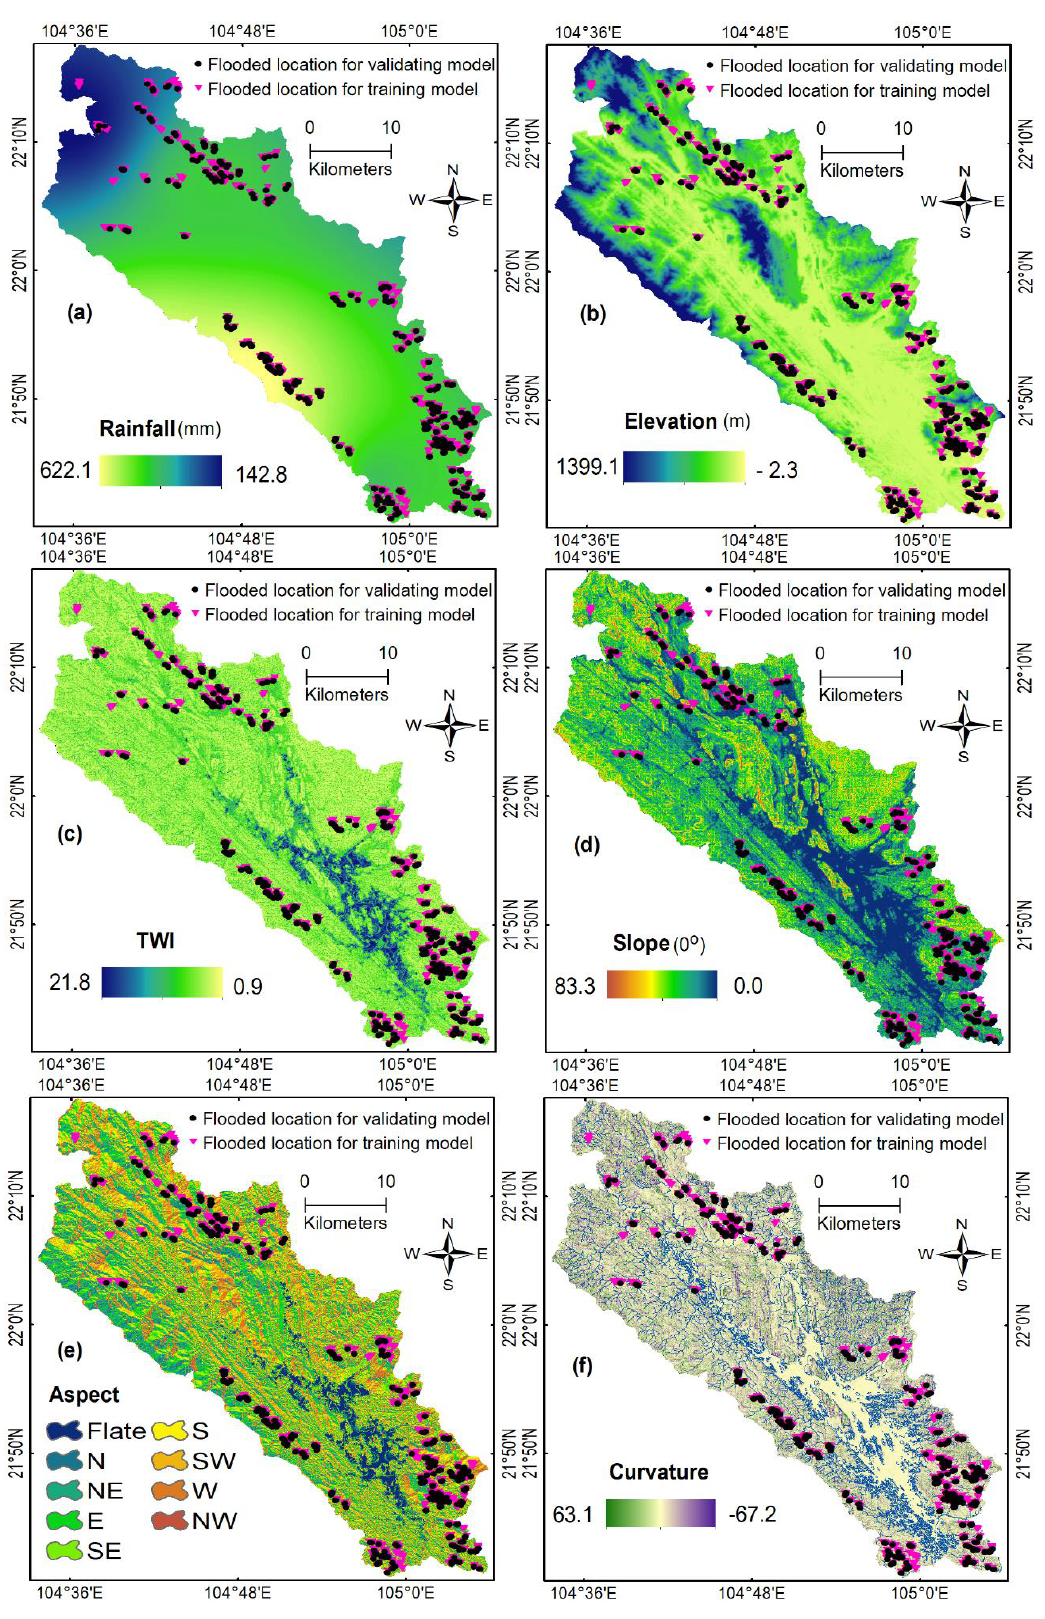
Figure 3. Flash-flood-influencing factors: ( a ) Rainfall, ( b ) Elevation, ( c ) TWI, ( d ) Slope, ( e ) Aspect, and ( f ) curvature.